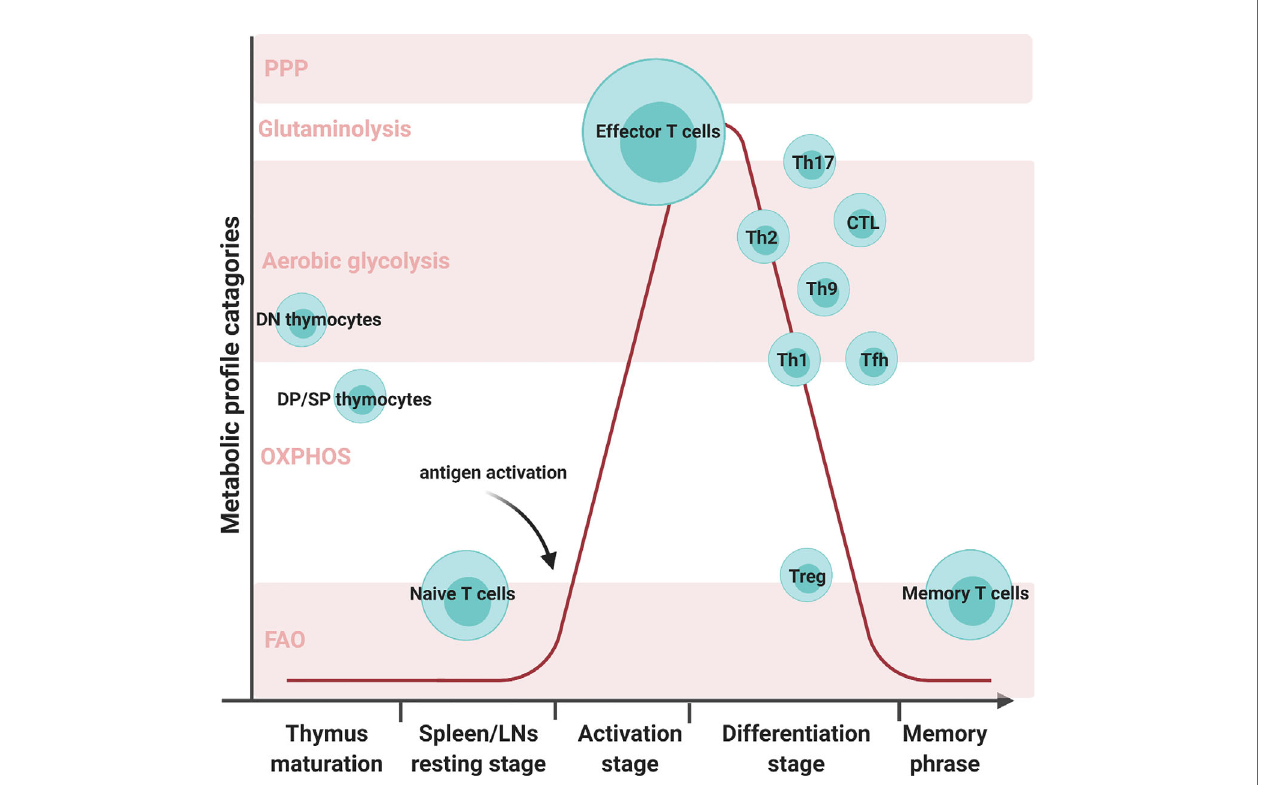
FIGURE 1 | Various T cell subsets development with metabolic reprogramming status. There are fi ve metabolic pro fi le categories: the pentose phosphate pathway, glutaminolysis, aerobic glycolysis, oxidative phosphorylation (OXPHOS), and fatty acid oxidation (FAO). Different T cell subsets alter their metabolic status at different developmental stages. Double negative (DN) cells are the initial stage of thymocytes. These cells will mainly use aerobic glycolysis during proliferation. In later stages of thymocyte development, double-positive (DP) cells and single CD4 or CD8 T cells mature and prepare to migrate through the bloodstream to the secondary organs. During this stage, the matured thymocytes preferentially utilize OXPHOS and FAO to meet their metabolic needs. Naive T cells in spleens and LNs continue in quiescence as thymocytes to minimize energy consumption. Once encountering antigens, T cells activate and proliferate to face foreign assailants. In order to combat foreign pathogens, effector T cells transition their metabolism from OXPHOS to aerobic glycolysis. T cells will progress into the differentiation stage where there are multiple T-cell subsets, such as T helper 1 (Th1), T helper 2 (Th2), T helper 9 (Th9), T helper 17 (Th17), regulatory T (Treg), and T follicular B helper (Tfh) cells. Although all T cell subsets utilize aerobic glycolysis, the varying subsets employ different metabolic processes. Th17 can utilize glutaminolysis and both Th1 and Tfh can conduct OXPHOS in addition to aerobic glycolysis. Memory T cells exhibited both OXPHOS and FAO to maintain their